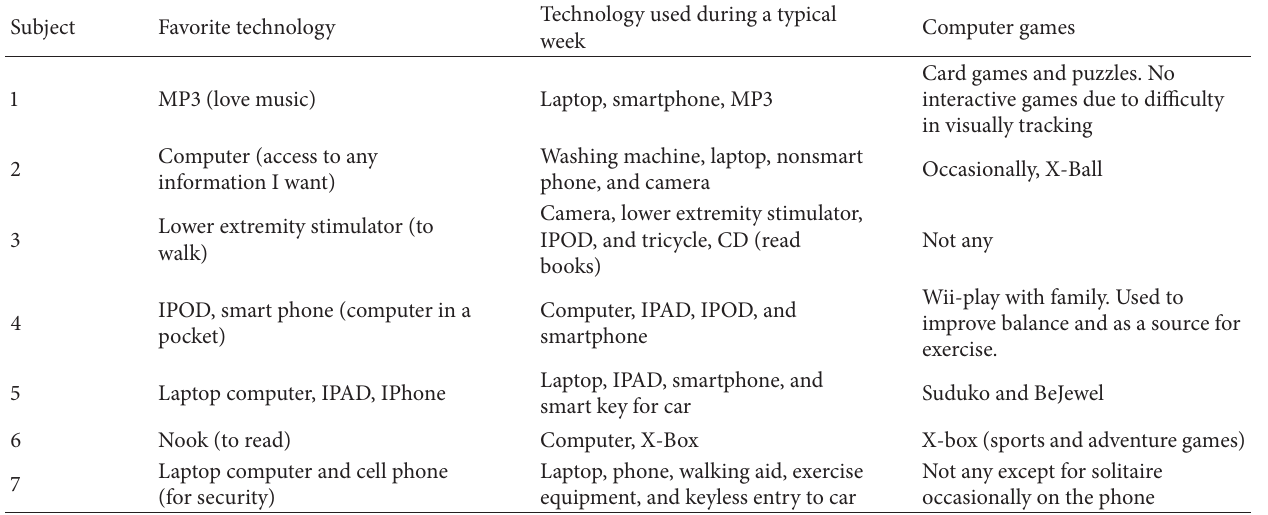
Table 2: Use of technology in daily